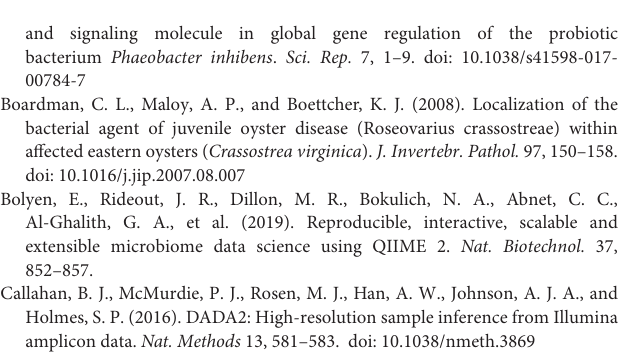
Supplementary Figure 1 | Heat map triangle showing average inter-group Bray-Curtis similarities of the bacterial communities between tissue types. The circles show the average within-tissue type similarities and larger circles and numbers represent greater similarities within and between tissue types. Supplementary Figure 2 | Heat map triangle showing average inter-group Bray-Curtis similarities of the Vibrio communities between tissue types. The circles show the within-tissue type similarities and larger circles and numbers represent greater similarities within and between tissue